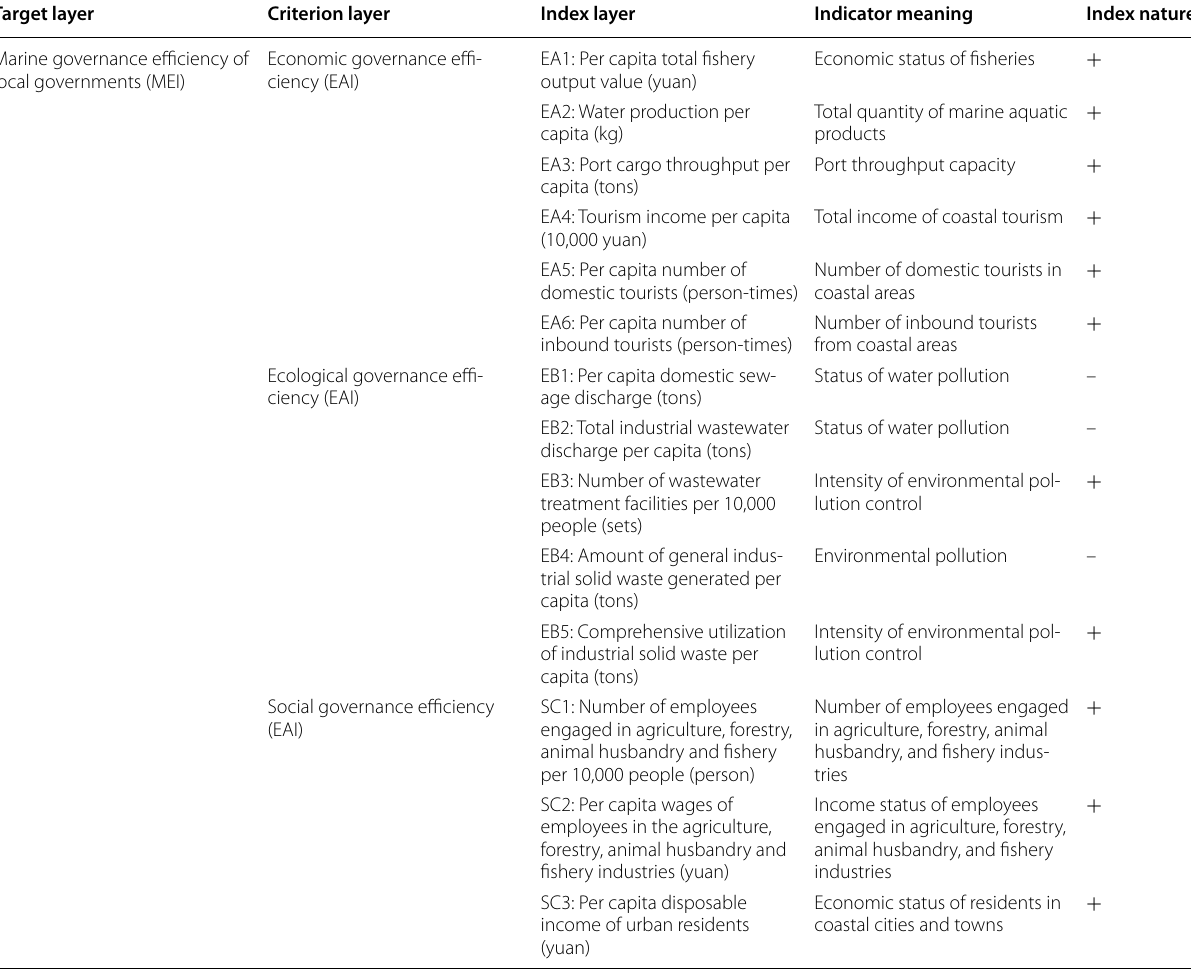
“ ” is a positive indicator + “-” is a negative